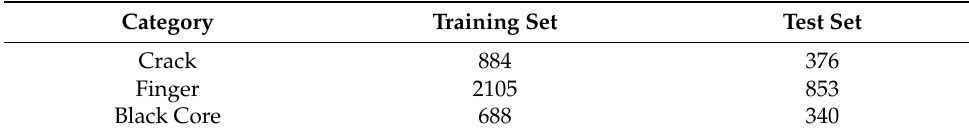
Table 1. Dataset